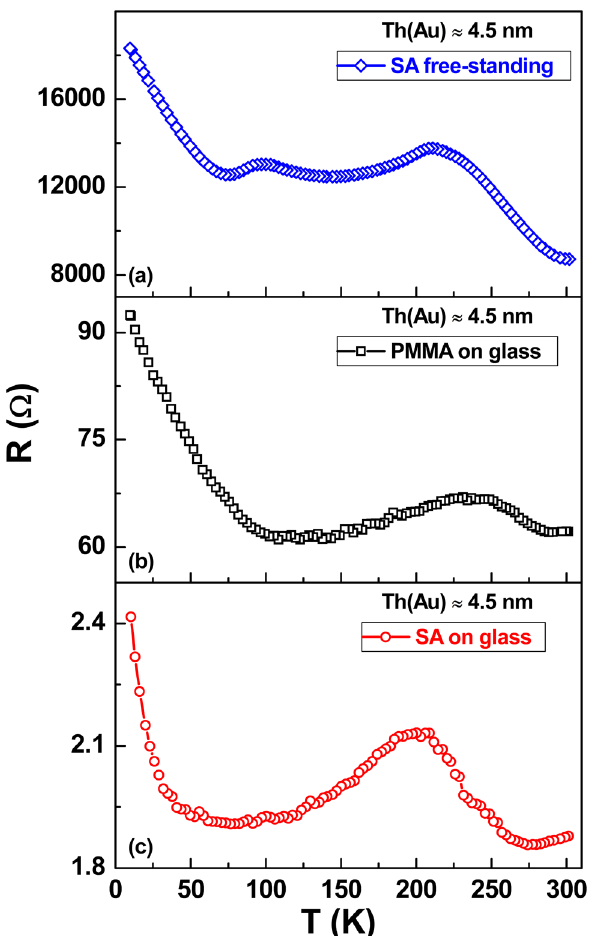
Figure 1. Resistance versus temperature plots of non-metallic films. The data refer to three different investigated samples covered with a 4.5 nm-thick Au layer: ( a ) SA free-standing film (blue diamonds), ( b ) PMMA deposited on glass (black squares), ( c ) SA deposited on glass (red